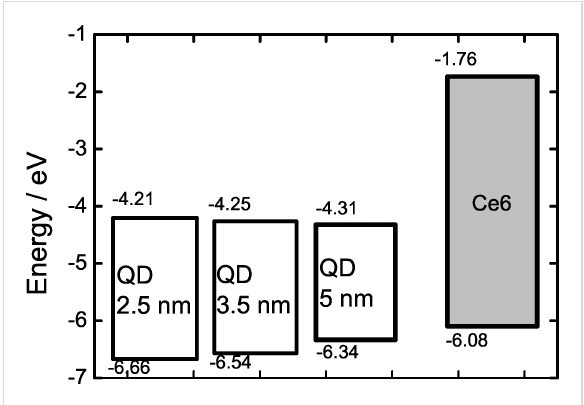
Figure 6: Energy level diagram of CdSe/ZnS QDs used in this work and Ce6 from [22]. The size of QD is shown in corresponding boxes.